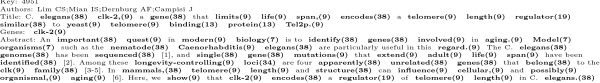
The LDA topics most associated with words in the CGC item shown in Figure
1. A word is identified with the topic k given in parenthesis
when the document-specific, variational posterior topic probability
exceeds a threshold,
φn(zn=
k) > 0.9. As illustrated by "telomere (9)", identical words
within a document are generated by the same topic. Note that only the
Title, Genes and Abstract records were concatenated and processed to
generate the bag-of-words document used to estimate the LDA.